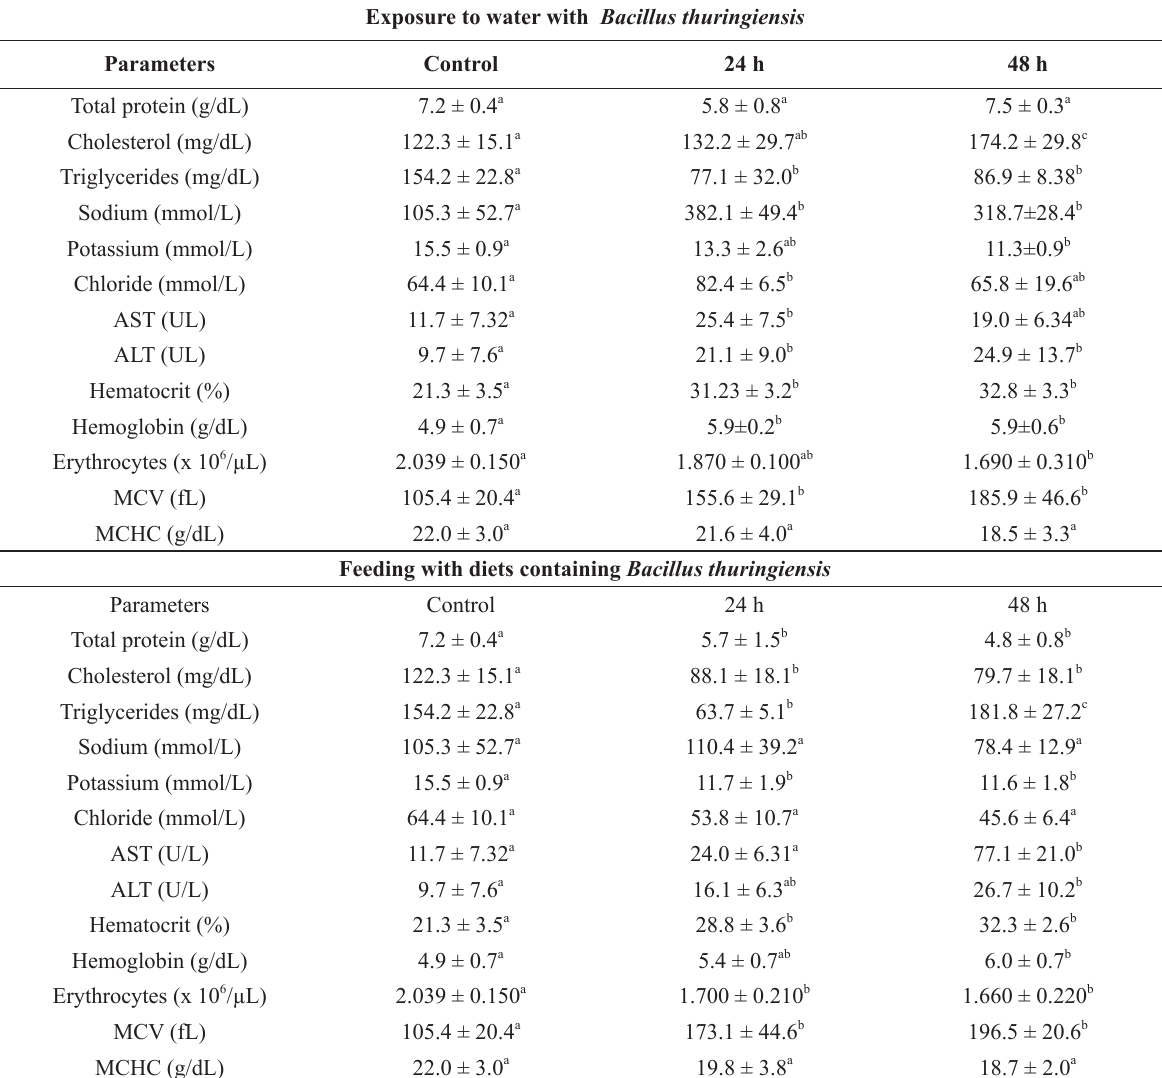
Blood parameters of Piaractus mesopotamicus exposed to biopesticide based on Bacillus thuringiensis. Exposure to water with Bacillus